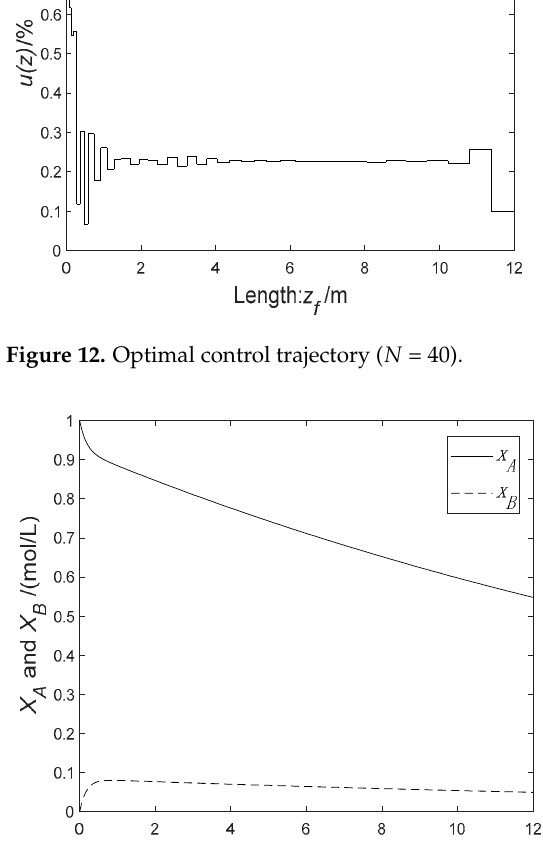
Figure 13. Optimal state variable trajectory.